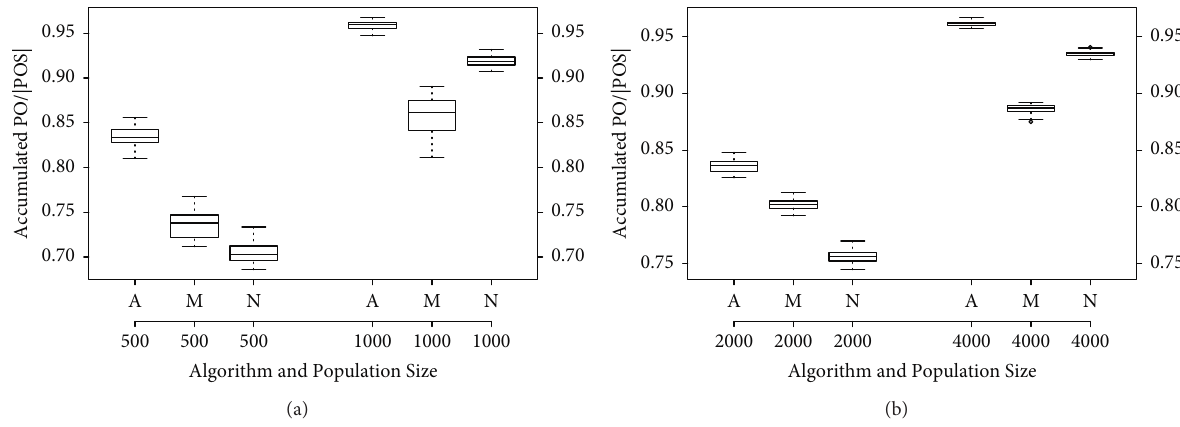
Figure 2: Ratio of accumulated number of Pareto optimal solutions found to the size of the POS. Population sizes 500 , 1000 { } and 2000 , 4000 { } for 4 and 5 objectives, respectively. Algorithms A ϵ S ϵ H ( A ) , MOEA/D ( M ), and NSGA-II ( N ). (a) M � 4 objectives and (b) M � 5